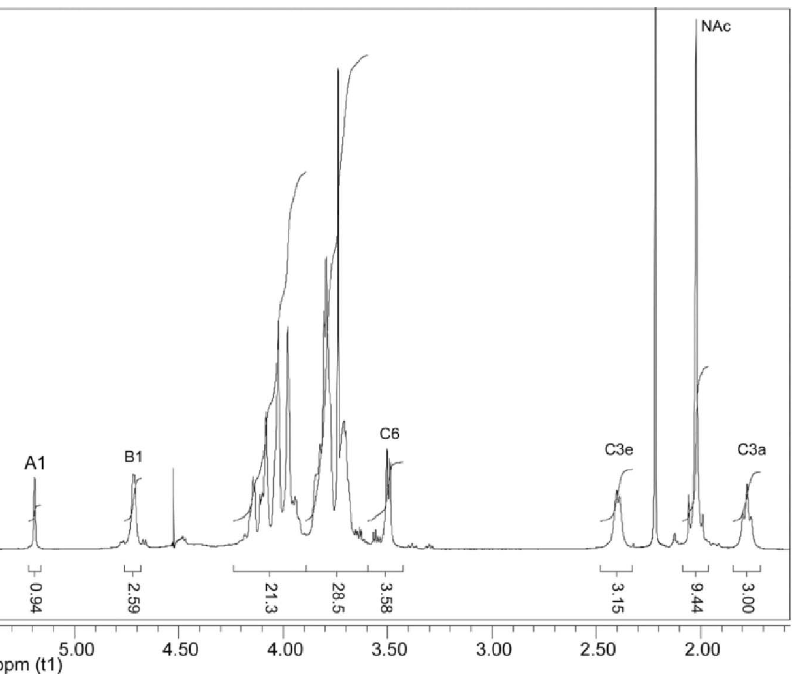
Figure 2. 1-D proton NMR spectrum of the polysaccharide. The integration values show the relative molar ratio of the two polysaccharides, A m and (B–C) n of about 1:3. For numbering, see Table 3 (C3e and C3a designate the equatorial and axial proton, respectively, of the C-3 methylene